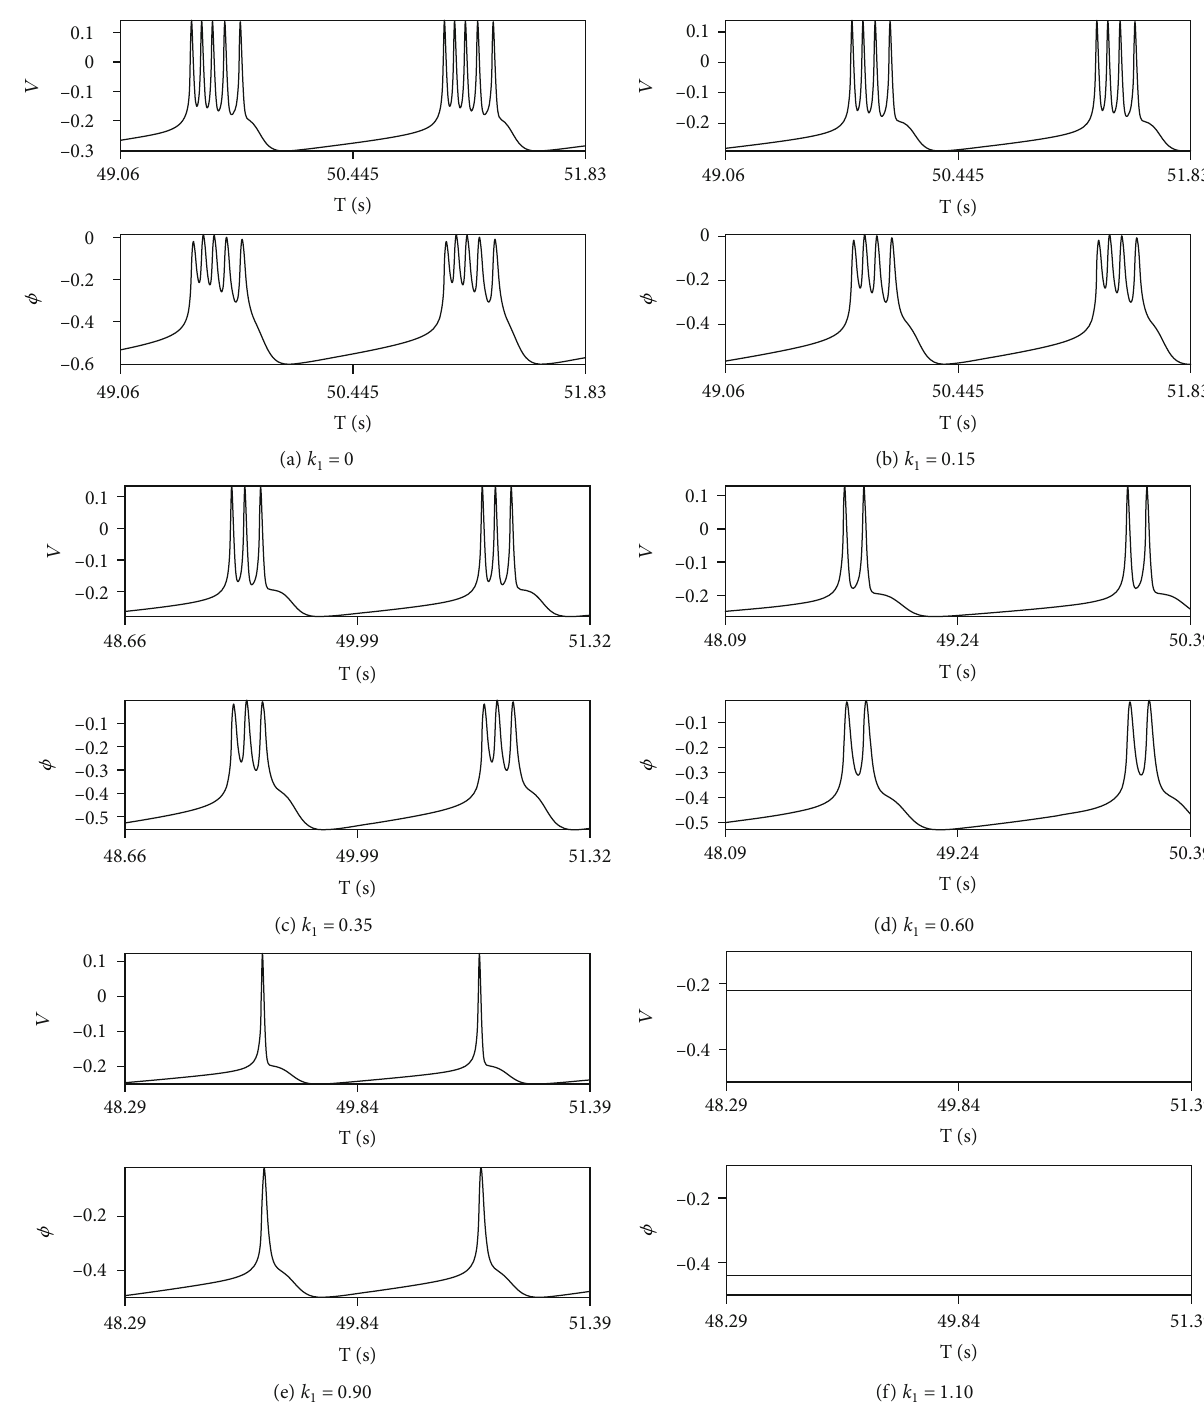
Figure 6: The neuron fi ring modes and magnetic fl ux ϕ without astrocyte